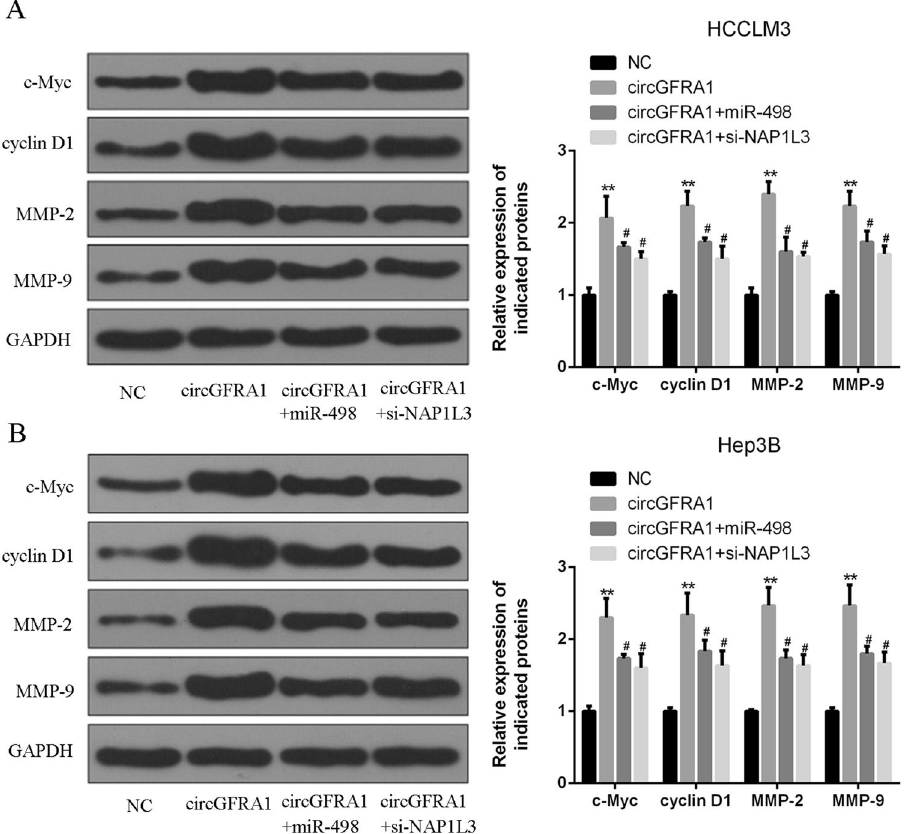
Figure 5. CircGFRA1 over-expression promoted NAP1L3-related signaling pathway in HCC cells. ( A , B ) Western blotting for c-Myc, cyclin D1, MMP-2, MMP-9 and GAPDH protein in HCCLM3 and Hep3B cells co-transfected with circGFRA1 or control and miR-498 mimics or si-NAP1L3. *vs. control vector group, # vs. circGFRA1 group. **P < 0.01, # P < 0.05.